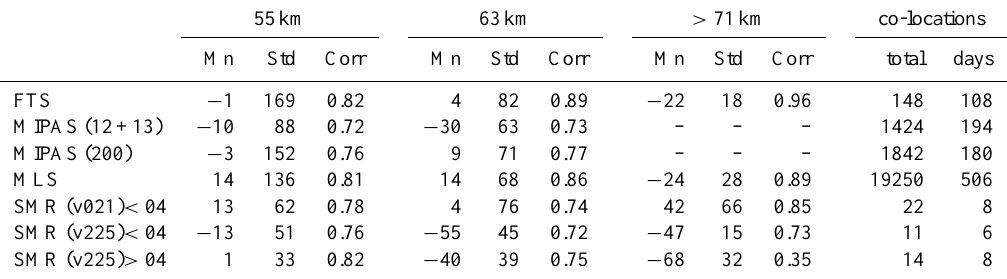
Table 4. Statistics for 55km, 63km and for total columns > 71km. Mn (%) the mean relative difference of CO between satellite and OSO ( > 0 if the satellite reports more CO than OSO), Std (%) the mean standard deviations, Corr the mean correlation of CO between satellite and OSO, total the total number of co-located measurements, days the number of days with co-located measurements. The summer values are